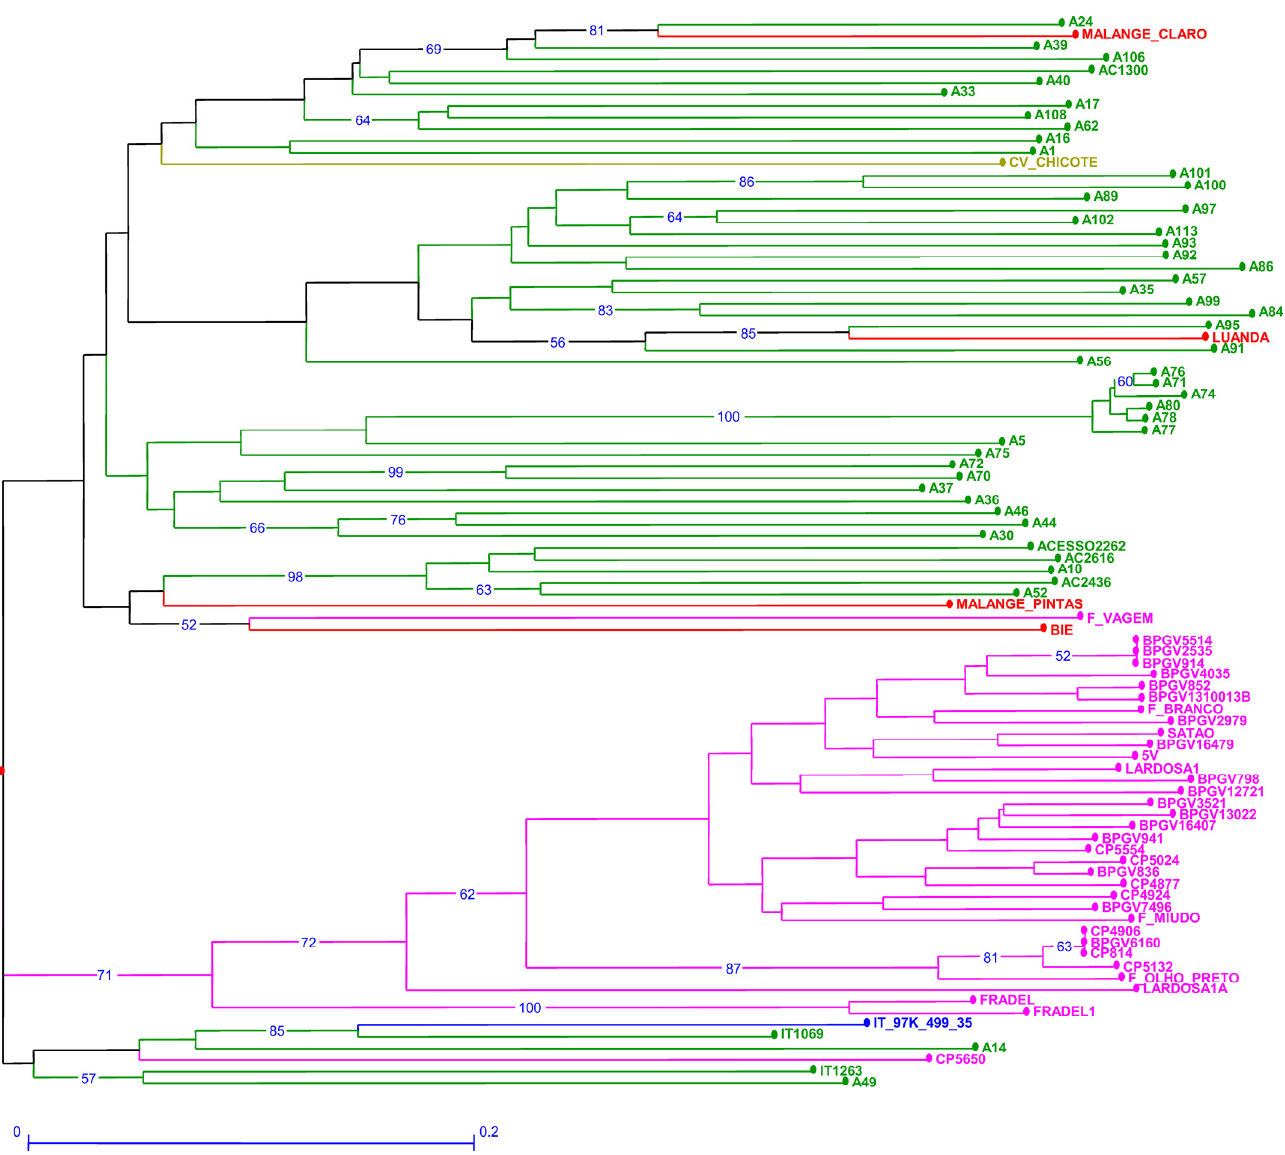
Figure 3. Neighbor joining dendrogram of cowpea genotypes, identified by SilicoDArT markers. Numbers associated with branches indicate bootstrap values (BS) based on 20,000 replications. Only BS values above 50 are shown. Branch lines represent individual accessions grouped by country (red: Angola, olive green: Cape Verde; green: Mozambique; blue: Nigeria and pink: